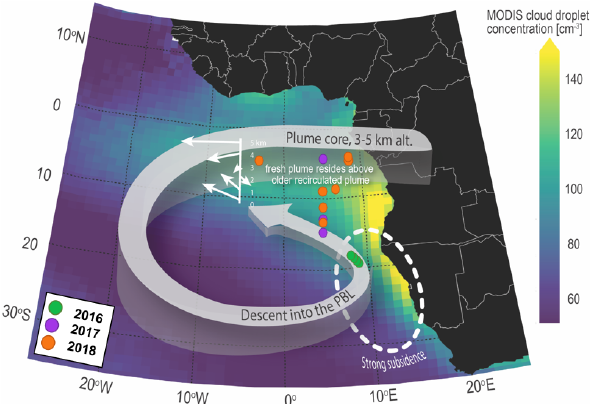
Figure 5. Adapted from Redemann et al. (2021), this schematic shows the commonly occurring trajectory of smoke aerosols ejected over the southeast Atlantic. Overlaid are approximate locations of collocated observations from 2016 (green), 2017 (purple), and 2018 (orange). By comparing their locations to the schematic, we hypothesize that the collocated observations made in 2016 are older aerosols, while collocated observations of aerosols in 2017 and 2018 are likely fresher and more recently ejected from the smoke plume.